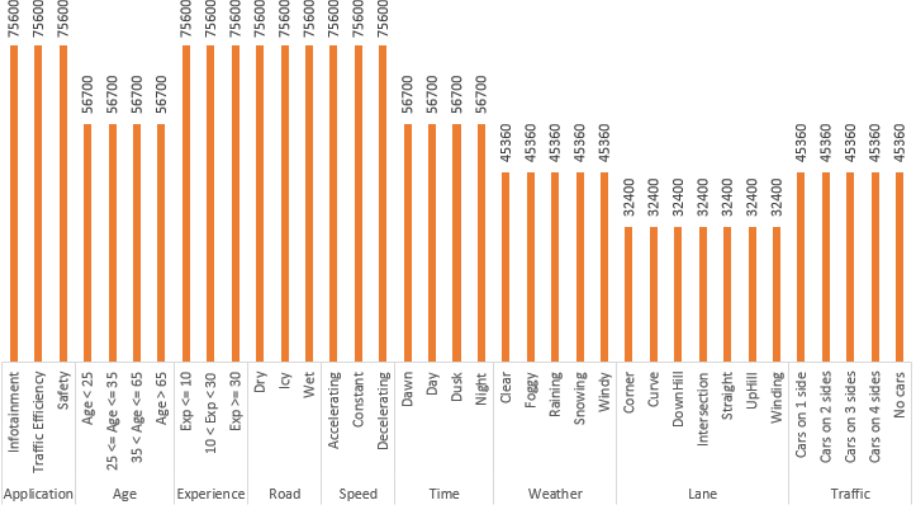
Figure 12. Frequency of each attribute in the